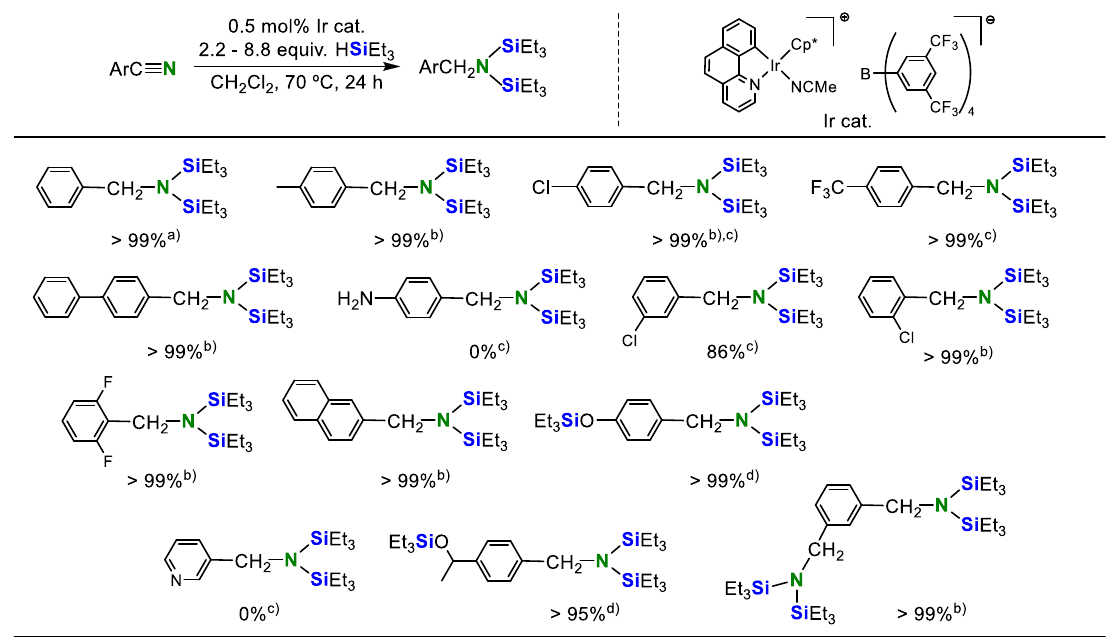
Table 5. Ir-catalyzed double hydrosilylation of aryl nitriles a .